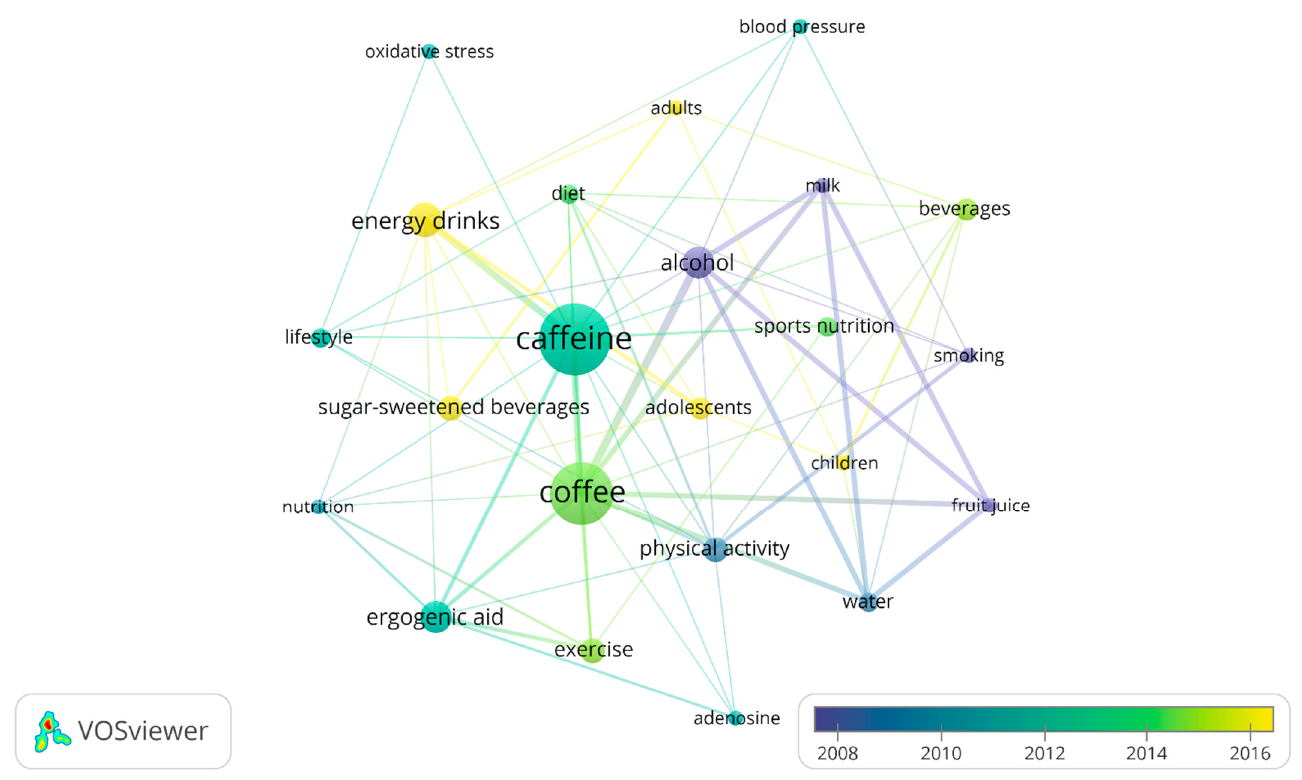
Figure 9. Temporary keywords plus graph.